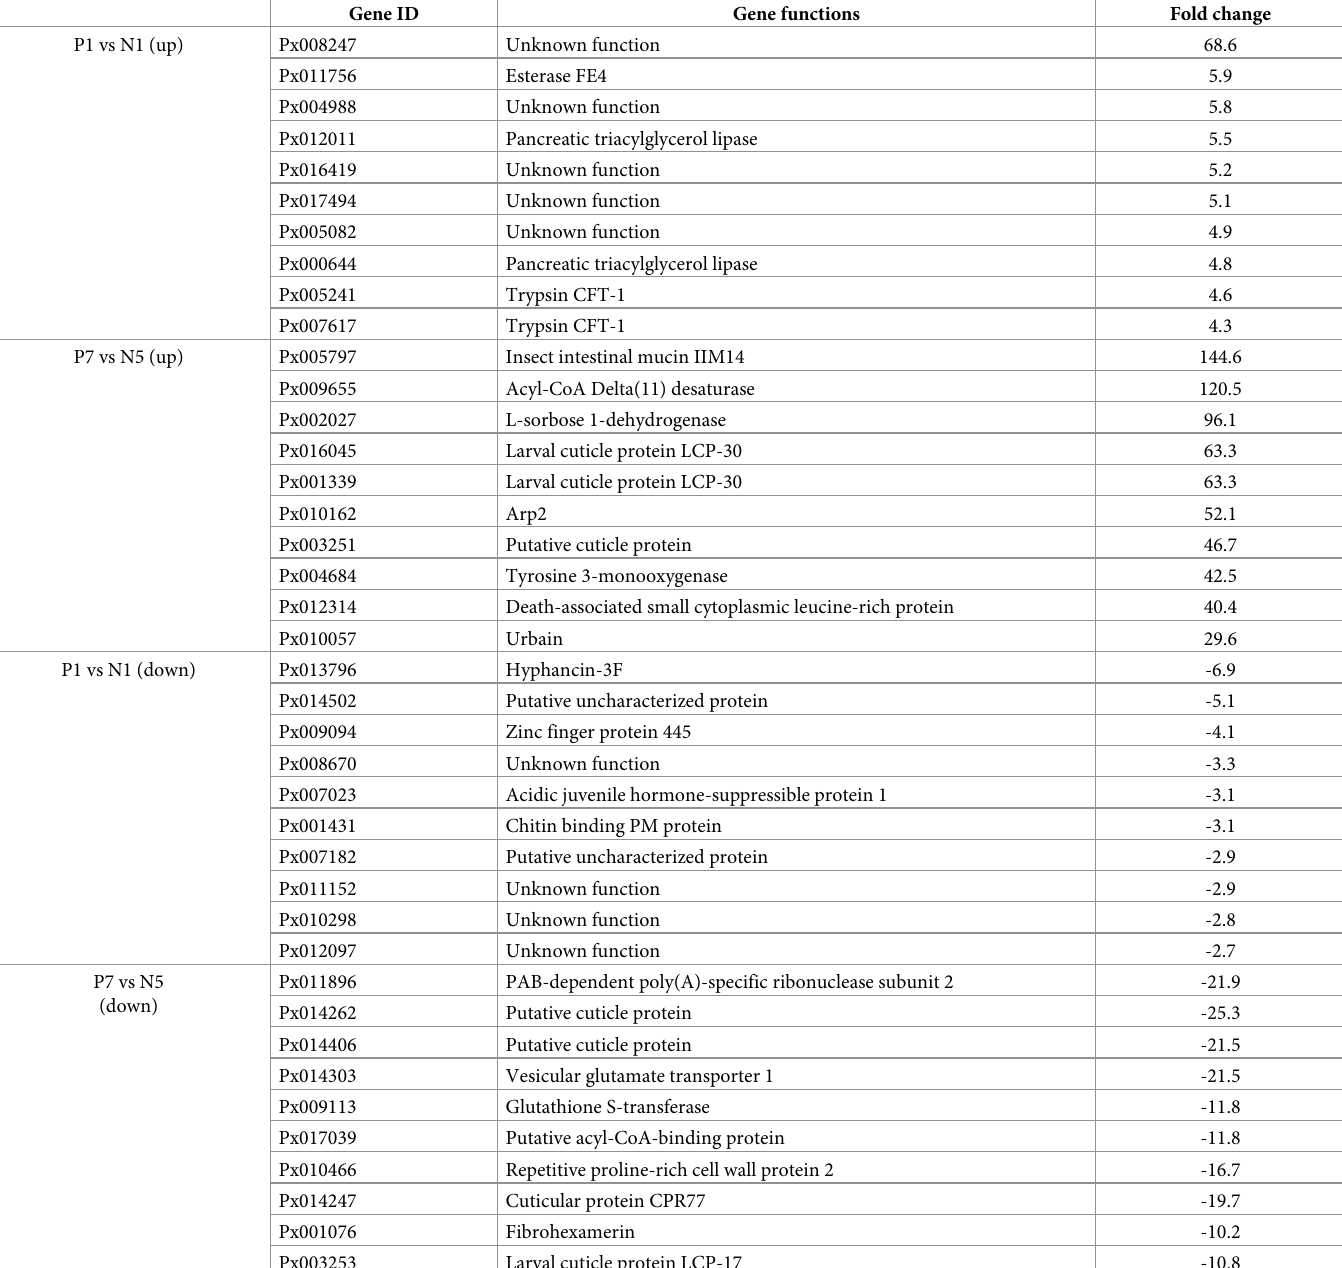
Table 2. Top 10 highly regulated genes of P . xylostella parasitized by C . plutellae at early (P1) and late (P7) stages. Gene ID Gene